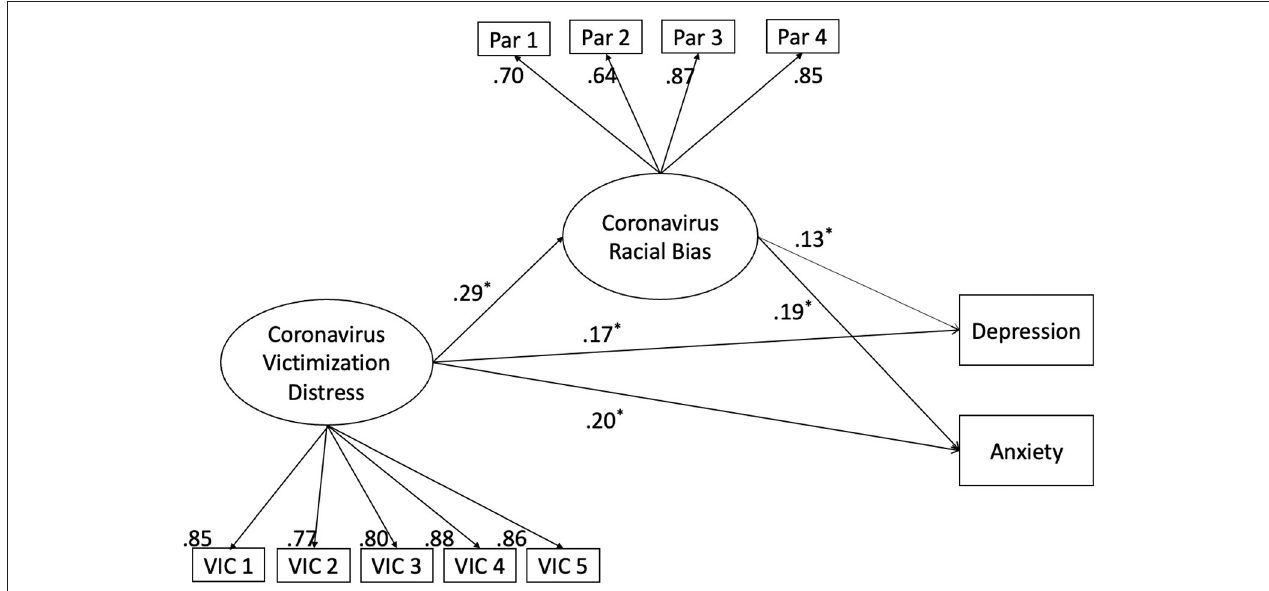
FIGURE 2 | Standardized results for main structural equation model with bootstrapping approach testing the mediating effect of coronavirus racial bias on the association between coronavirus victimization distress and depression and anxiety. Covariates included race/ethnicity, COVID-19 health risks, employment change distress, housing changes, age, household income, and education level. *represents statistically significant results based on 95% Confidence